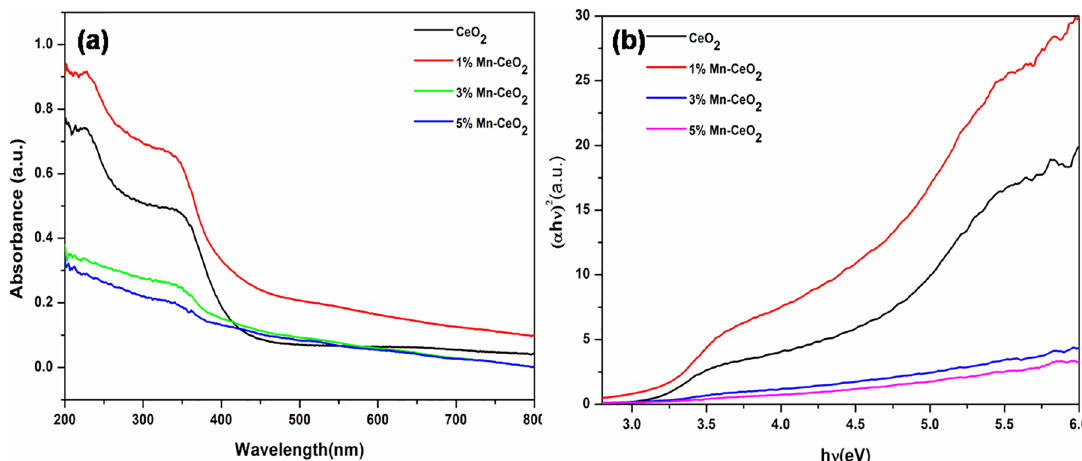
with varying Mn/Ce molar ratio; (b) Plot of ( αhν ) 2 versus photon energy of pure 2